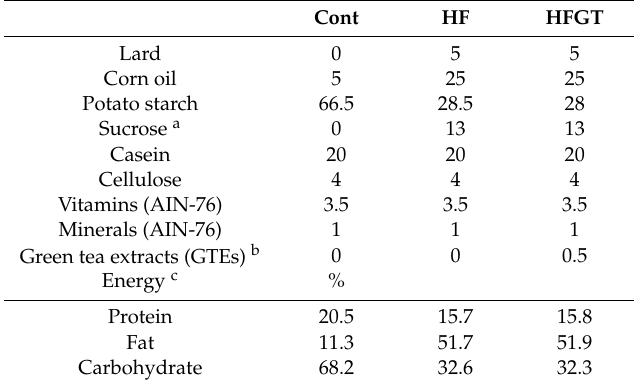
Table 1. Composition of experimental diets fed to mice.